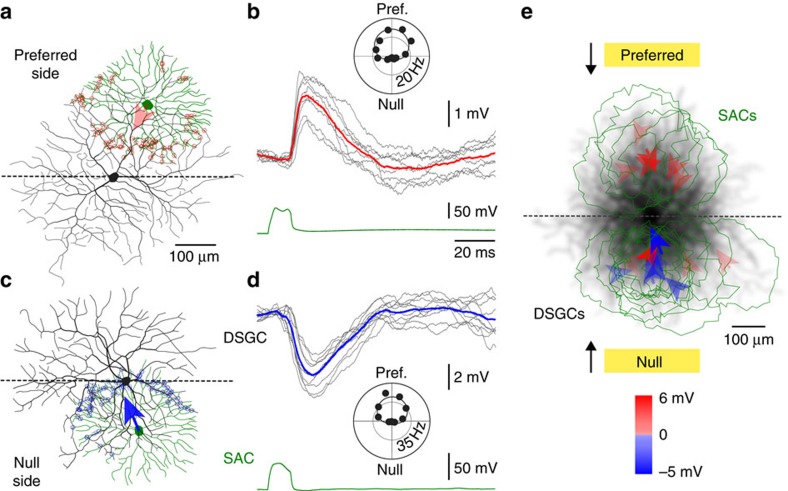
The impact of ON-SACs aligns with the directional tuning of postsynaptic ON-DSGCs.(a) Reconstruction of a connected pair of ON-SAC (green) and ON-DSGCs (black), showing the sites (red symbols), and vectorial angle (red arrow, relative to SAC somata) of close dendro-dendritic appositions. Morphologies have been aligned to the preferred direction vector of ON-DSGC light responses (b inset). In all panels the preferred side of the ON-DSGC, the dendritic field first activated by light stimuli moving in the preferred direction, lies above the horizontal dashed line. Note that the SAC somata and all dendro-dendritic close appositions are positioned on the preferred side of the postsynaptic ON-DSGC. (b) Paired recordings from the illustrated cells (a) revealed that activation of the SAC-evoked excitatory PSPs in the ON-DSGC (grey traces, red trace is a digital average). The somatic current-evoked presynaptic SAC voltage responses are shown below (green trace). (c) Reconstruction of an ON-SAC located in the null side of an ON-DSGC. The morphologies have been aligned to the ON-DSGC light response vector (d inset). (d) Paired recordings from the illustrated cells (c) revealed SAC-mediated inhibitory PSPs (grey traces, blue trace is a digital average). (e) Summary of the impact of SACs located on the preferred and null sides of postsynaptic ON-DSGCs. The morphologies of postsynaptic ON-DSGCs are shown as overlain and spatially filtered (50 μm, black) reconstructions registered to the preferred direction of light responses, shown schematically by the yellow light bars. Nested within this field are perimeter representations of SACs (green). Arrows indicate the vector angle of SAC-DSGC close dendro-dendritic appositions coloured according to their postsynaptic impact (red excitatory, blue inhibitory PSPs). Vector length represents 1 contact per μm. All light stimuli, the direction of which are schematically illustrated, were applied under photopic conditions. Stimulus intensity was twice that of background illumination.